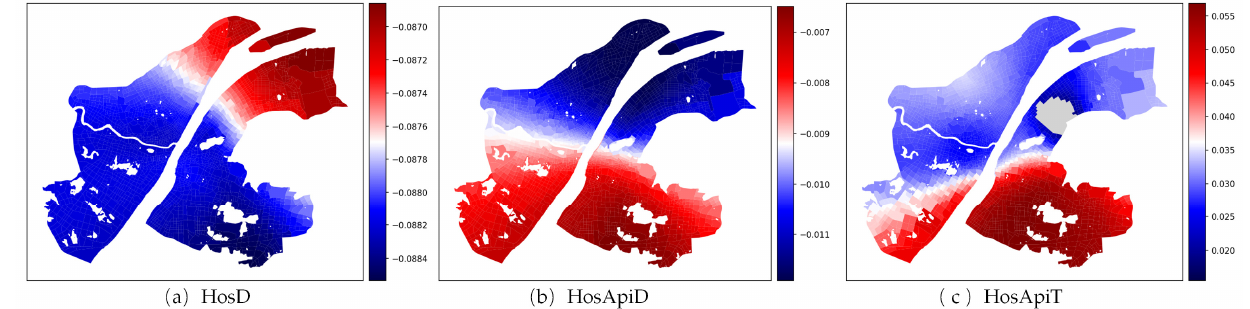
Figure 11. Global effect of hospital accessibility. ( a ) Distance to nearest hospital, ( b ) Travel distance to nearest hospital calculated by Baidu Map API, ( c ) Travel time to nearest hospital calculated by Baidu Map API.